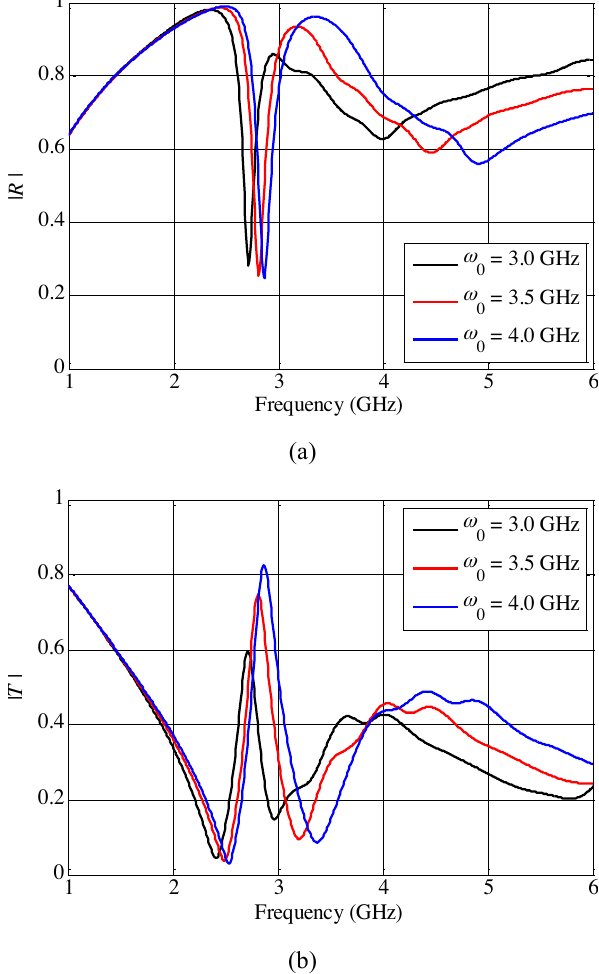
Figure 4. Reflection (a) and transmission (b) spectra of the array placed on a ferrite substrate magnetized in z - direction for different ω 0